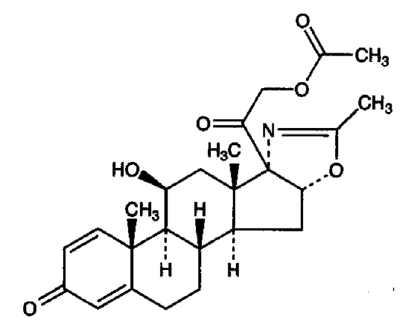
FIGURE 1 - Chemical structure of